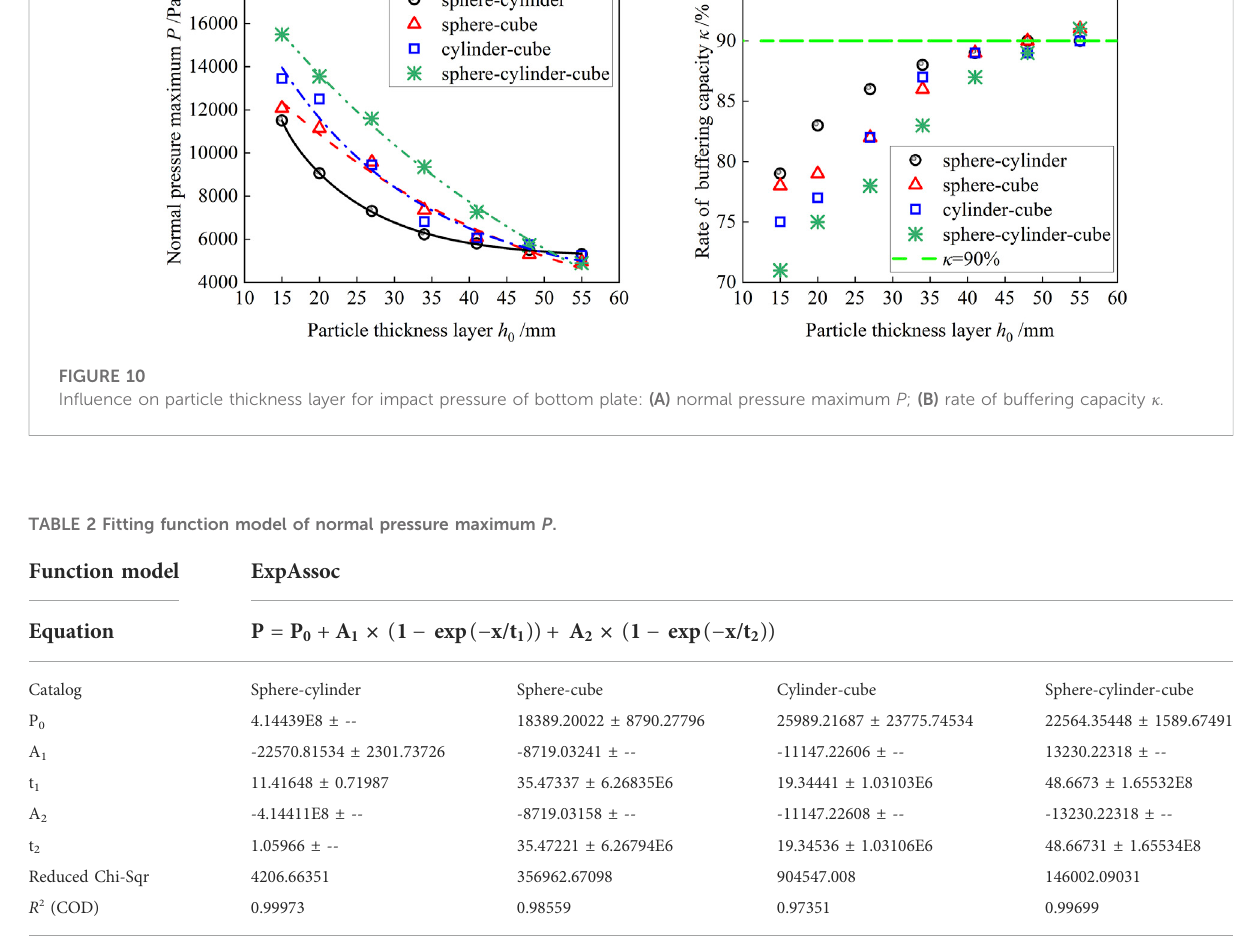
gradually with the increase of buffer thickness. As shown in Figure 13B, the trends of the maximum translational energy of different types of soil buffers after impact with the thickness of soil buffers are relatively consistent, and the in fl uence of the shape of the buffer- fi lled particles on the translational energy of the buffer particles can be seen.